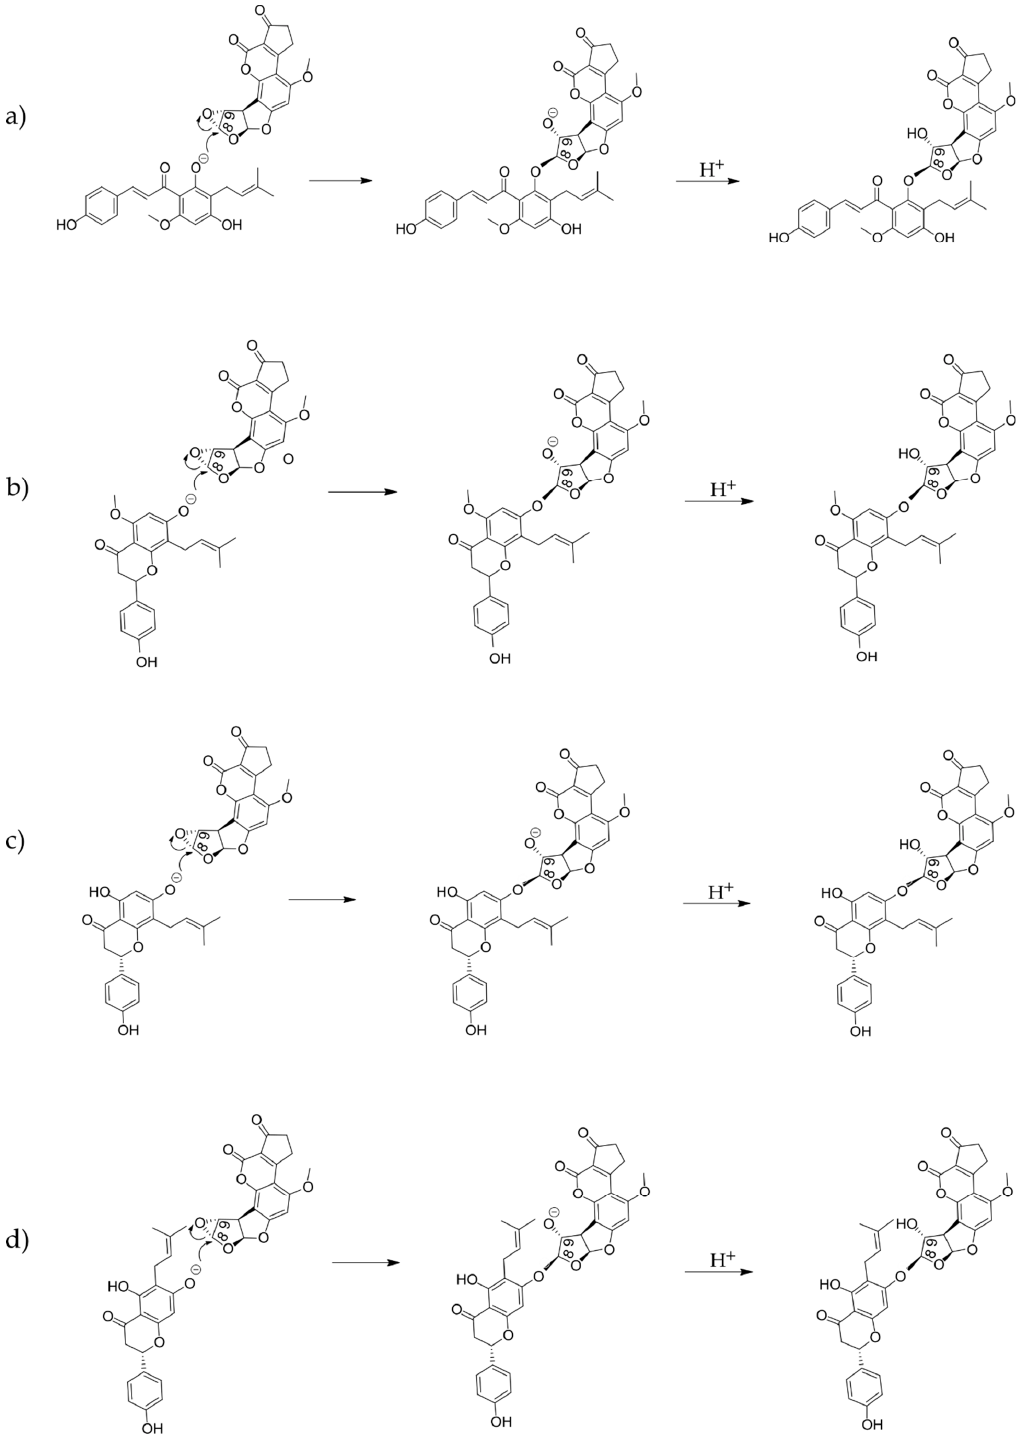
Figure A1. The reaction mechanisms proposed for the reactions of AFBO with ( a ) XN, ( b ) IXN, ( c ) 8 ‐ PN, and ( d ) 6 ‐ PN.